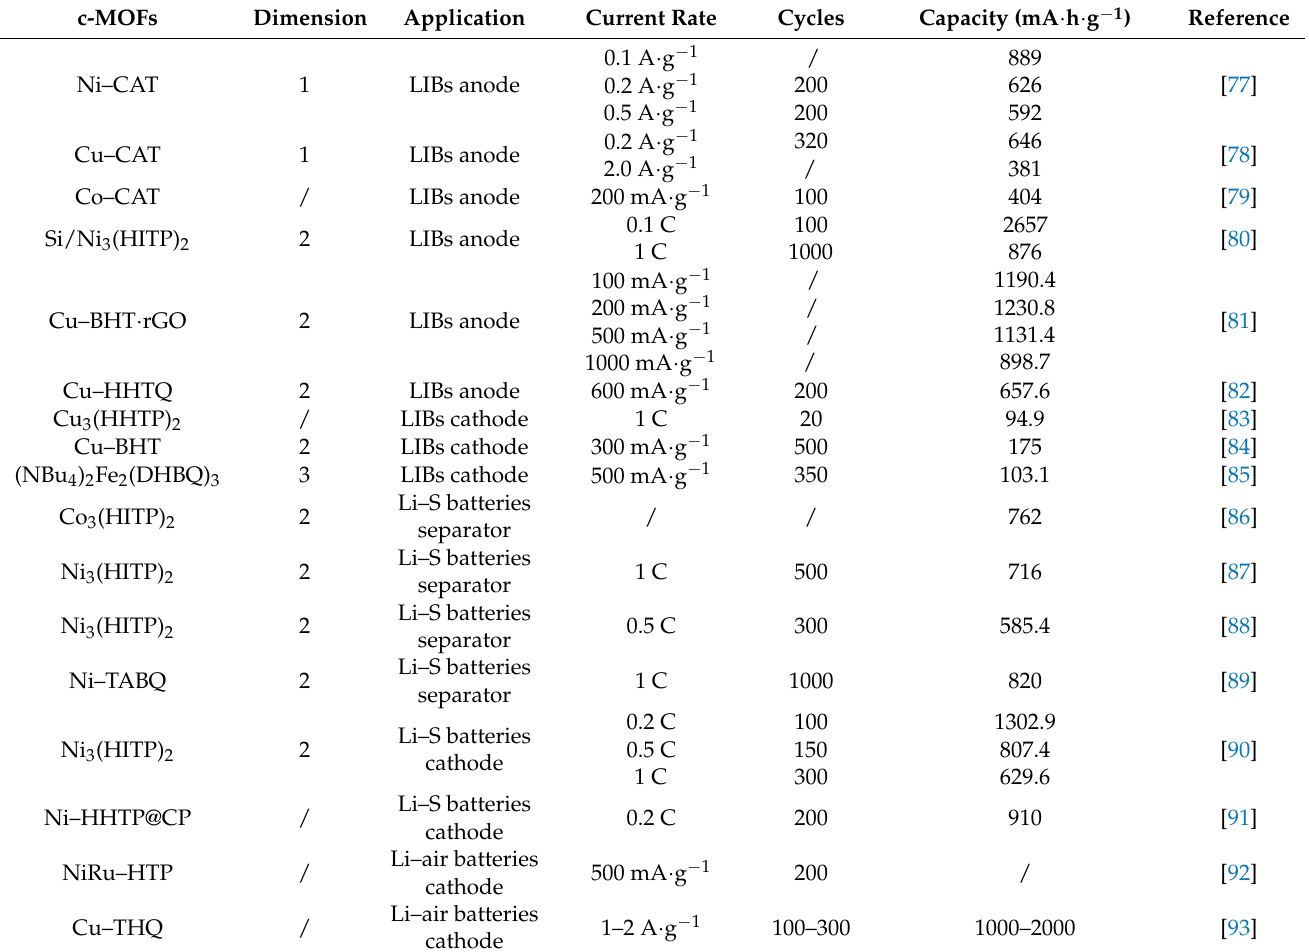
Table 1. Performance of c-MOFs in rechargeable lithium